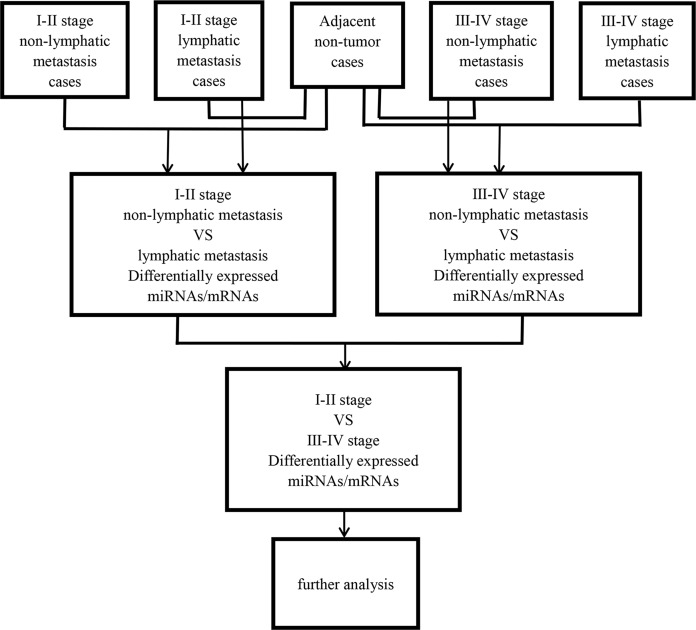
Flow chart for bioinformatics analysis.